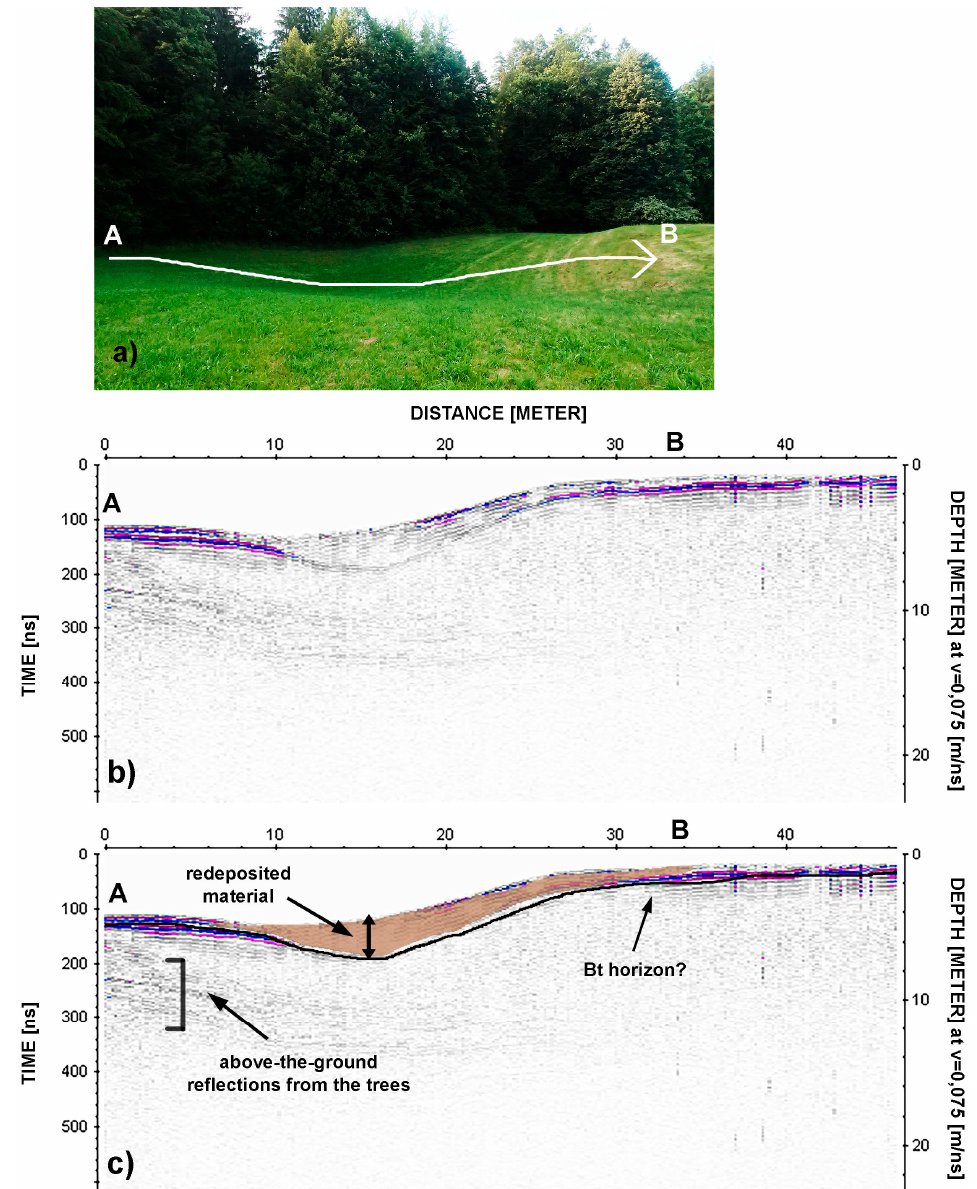
Figure 4. ( a ) The direction of Profile 1 acquired over a cultivated doline on old conglomerate (Poljšica). The right side of the doline is slightly terraced; ( b ) A processed and topographically corrected radargram; ( c ) An interpreted radargram.